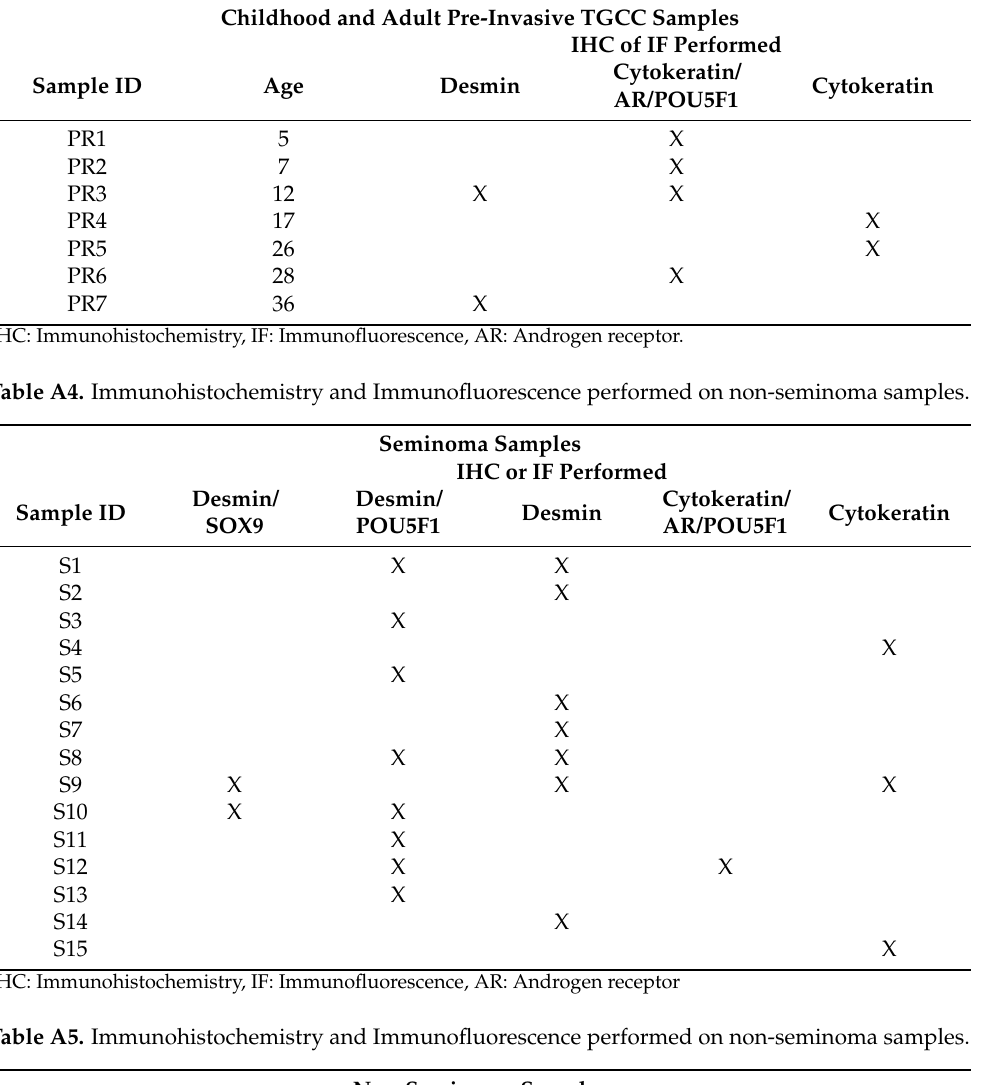
Table A3. Immunohistochemistry and Immunofluorescence performed on childhood and adult pre-invasive TGCC samples.